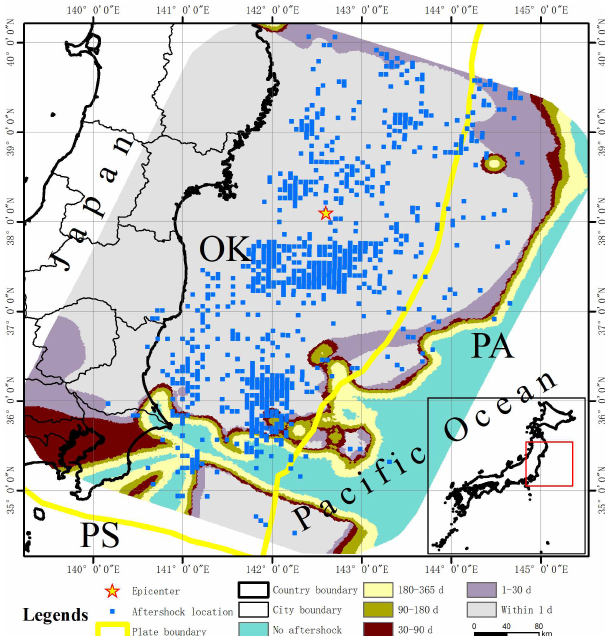
Figure 11. Aftershock hysteresis effect of the Tohoku earthquake in Japan. The aftershock hysteresis effect can be observed by com- bining the aftershock patterns of the Tohoku earthquake at different timescales. The blue dots indicate the locations of the actual after- shocks over 1